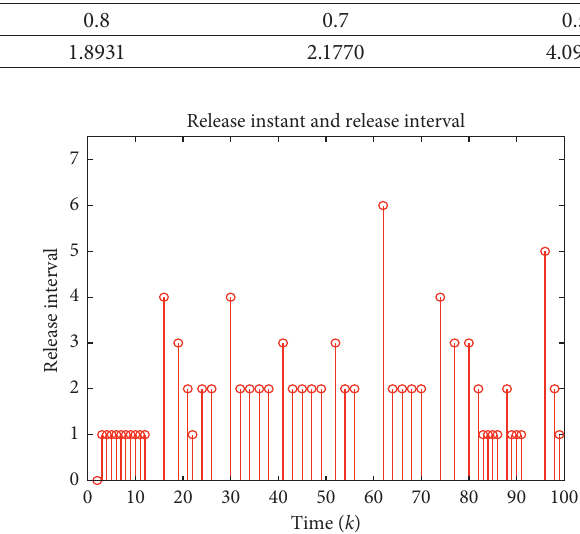
Figure 3: The release instants and their interval in Case 1.